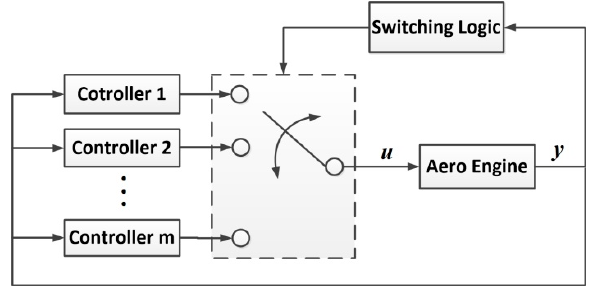
Figure 1. Schematic diagram of multi-loop switching strategy.